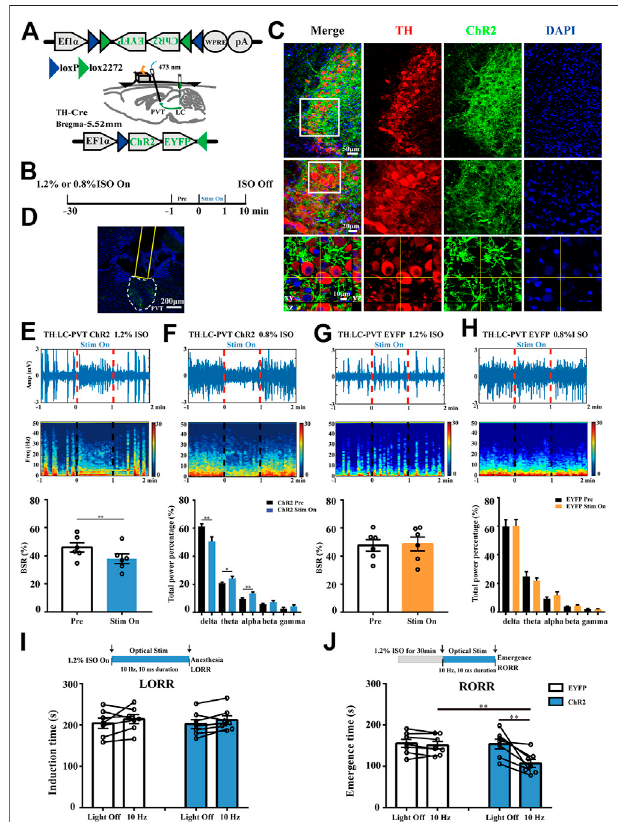
FIGURE 5 | Optogenetic activation of TH:LC-PVT terminals promotes arousal from iso fl urane anesthesia. (A) Schematic of bilateral LC injection, optic fi ber implantation and EEG recording. (B) Experimental protocol for opticalstimulation andEEG recording duringiso fl urane anesthesia. After 30 min inhalation of iso fl urane, the mice were optically stimulated for 1 min (stim on). (C) Speci fi c expression of ChR2-EYFP (green) in LC TH (red) neurons. Insets were ampli fi ed in below (D) Representative ChR2-EYFP terminalsandthelocationofoptical fi berinthePVT. (E,F) Arepresentativeraw EEG trace (top) and the corresponding power spectrum (middle) at 1 min before, 1 min during and 1 min after optical stimulation in ChR2 mouse during 1.2% (E) or 0.8% (F) iso fl urane anesthesia. BSR was calculated at 1 min before and 1 min during optical stimulation in ChR2 mice (bottom, n (cid:1) 6, two- tailed paired t-test, ** p < 0.01). EEG power percentage of different frequency bands at 1 min before (black) and 1 min during (blue) optical stimulation in ChR2 mice (bottom, n (cid:1) 6, the two-tailed paired t-test, * p < 0.05, ** p < 0.01). (G,H) A representative raw EEG trace (top) and corresponding power spectrum (middle) at 1 min before, 1 min during and 1 min after optical stimulation in EYFP control mouse during 1.2% (G) or 0.8% (H) iso fl urane anesthesia. BSR was calculated at 1 min before and 1 min during optical stimulation in control mouse (bottom, n (cid:1) 6, the two-tailed paired t-test). EEG power percentage of different frequency bands at 1 min before (black) and 1 minduring(blue)opticalstimulationincontrolmice(bottom, n (cid:1) 6,two-tailed paired t-test) (I) Experimental protocol for optical stimulation during 1.2% iso fl urane anesthesia induction (top) . Effects of activating TH:LC-PVT terminalsontheinductiontimeinEYFP(control)andChR2mice(bottom, n (cid:1) 7 in each group, two-tailed paired t-test). (J) Experimental protocol for optical stimulation during 1.2% iso fl urane anesthesia emergence (top) . Effects of activating TH:LC-PVT terminals on the emergence time in EYFP (control) and ChR2 mice (bottom, n (cid:1) 7 in each group, two-tailed paired t-test or two-tailed unpaired t-test, ** p < 0.01). Data shown as means ±